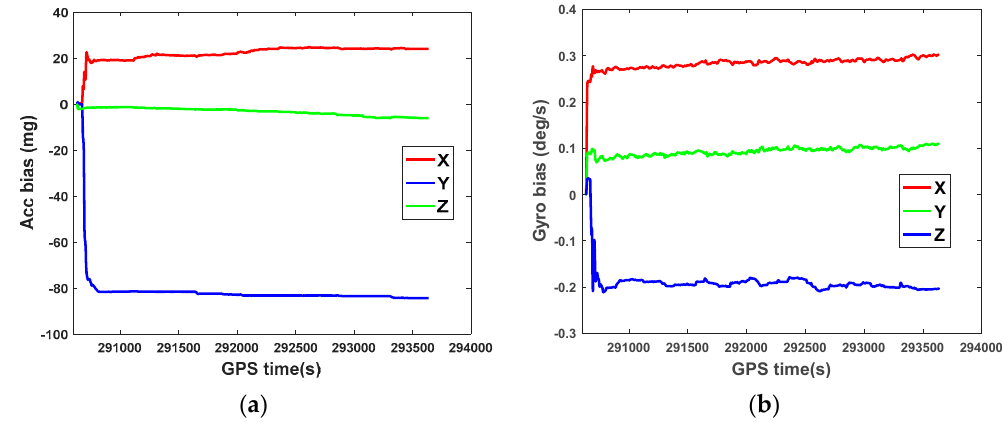
Figure 8. Accelerometer bias ( a ) and gyro bias ( b ) for IMU sensors.